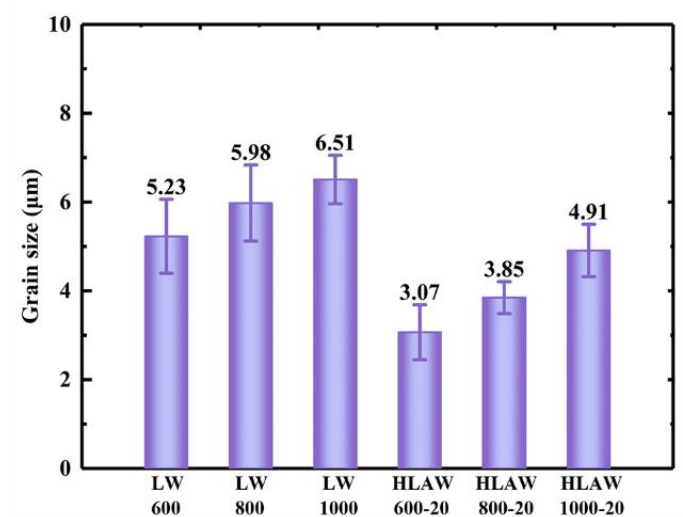
Figure 9. Grain size of welded joint under various parameters.